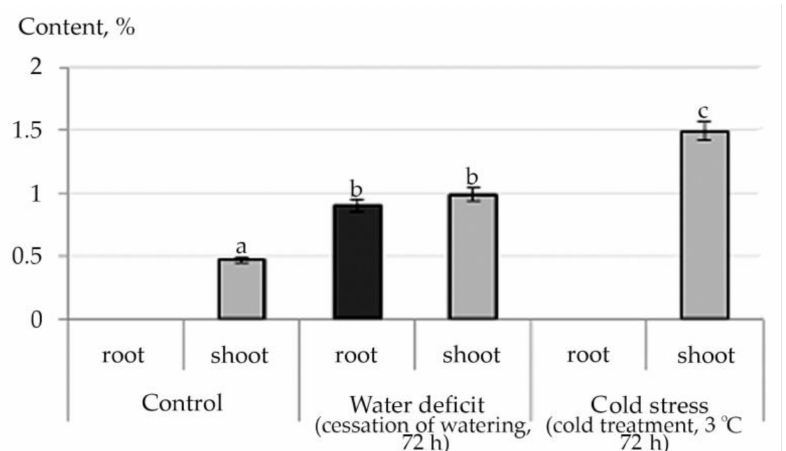
Figure 11. Change in the content of Hexadecanoic acid, 1-(hydroxymethyl)-1,2-ethanediyl ester in R. semenowii under stress conditions. Values presented are means ( ± SD). Different letters above the bars represent significant differences at p ≤ 0.05, n = 3 plants in each of 3 replicates for all